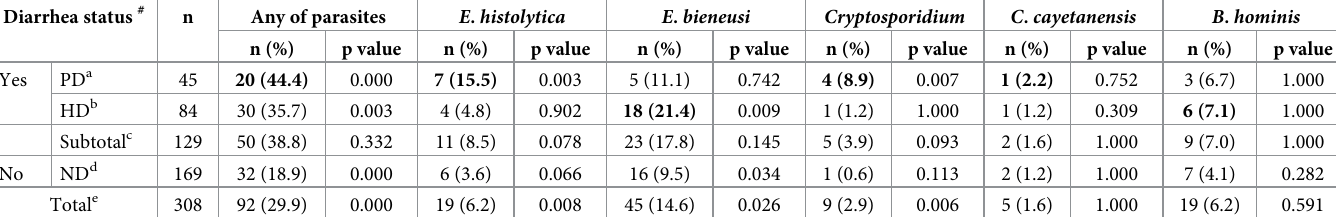
PD = present diarrhea. HD = historic diarrhea, as described in the methods. ND = non-diarrhea. Bold = the values statistically significant higher than that in the same group were shown in bold. #